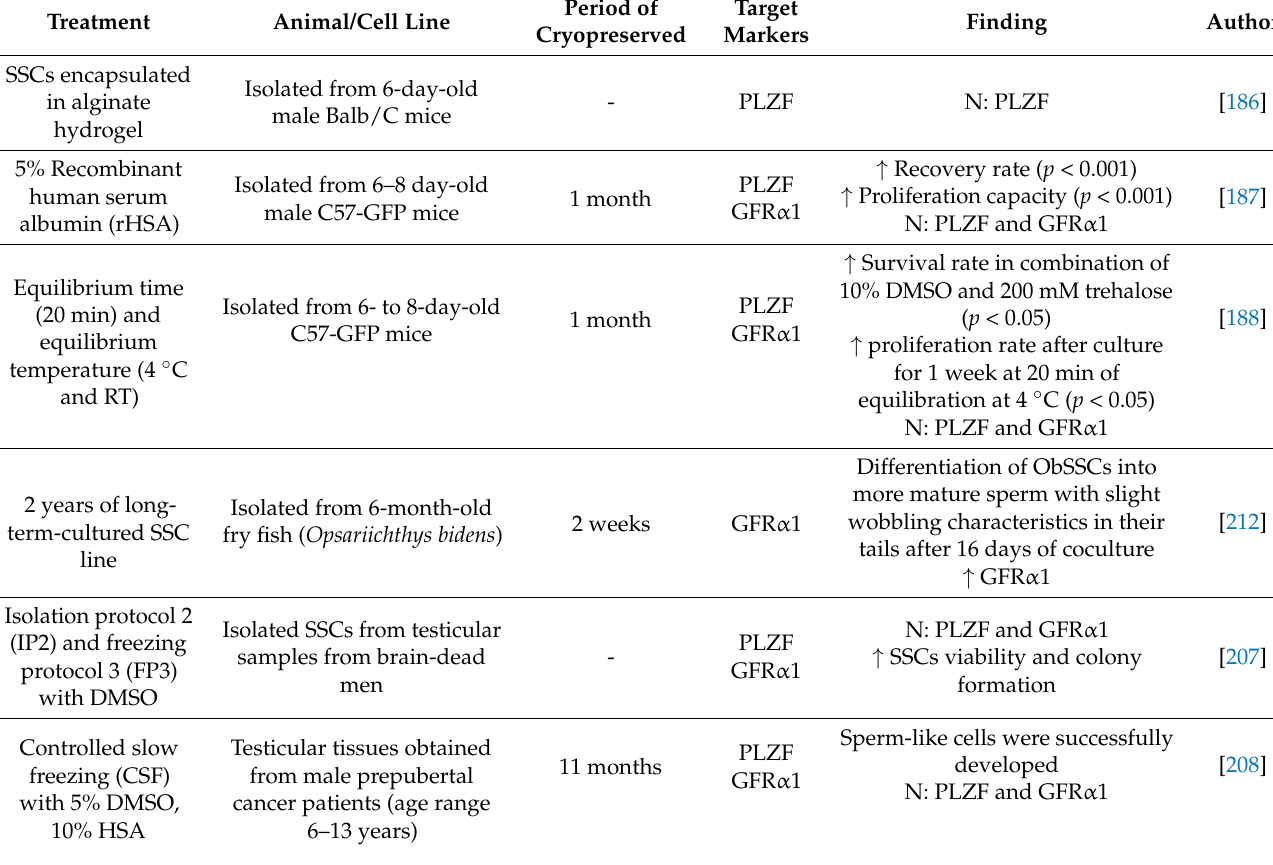
Table 2. The difference in cryopreservation protocols for assessing the functionality of